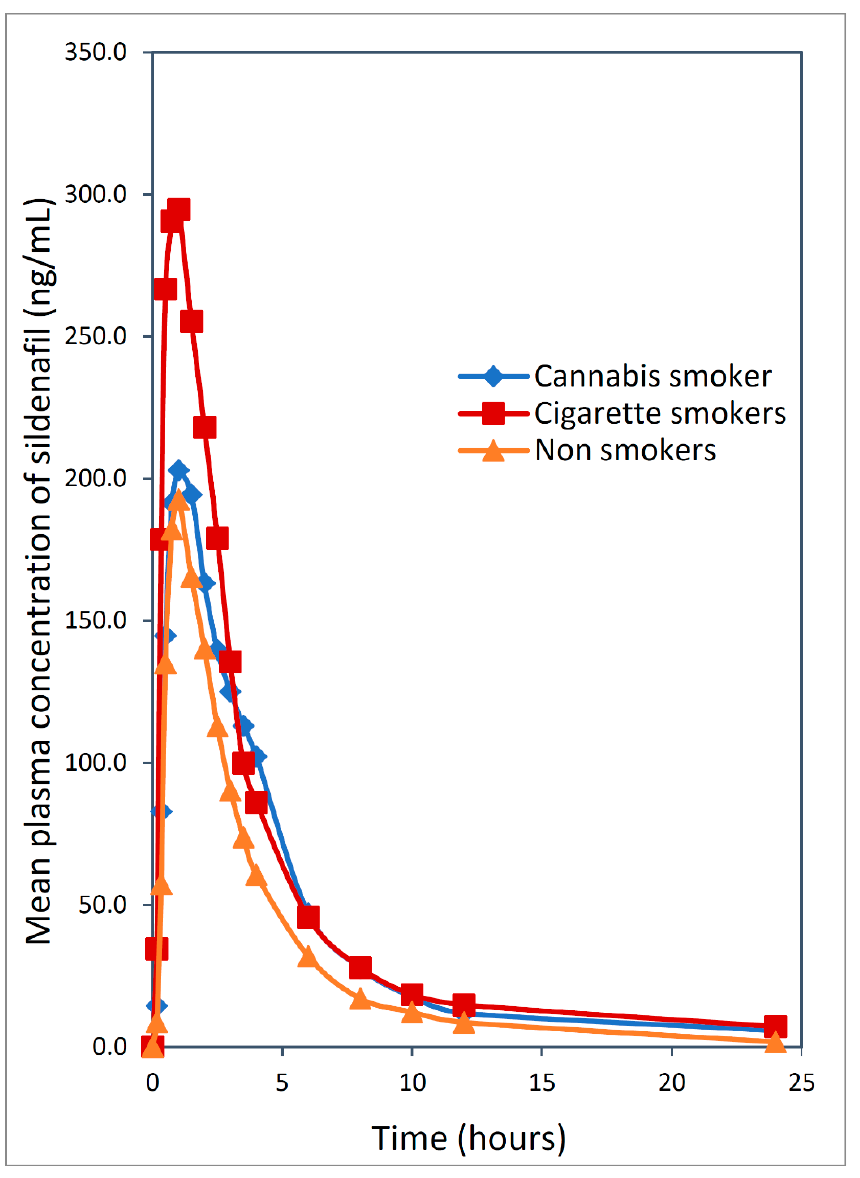
Figure 2. Mean sildenafil plasma concentration versus time curves after the oral administration of a single 50 mg dose of sildenafil in each group.